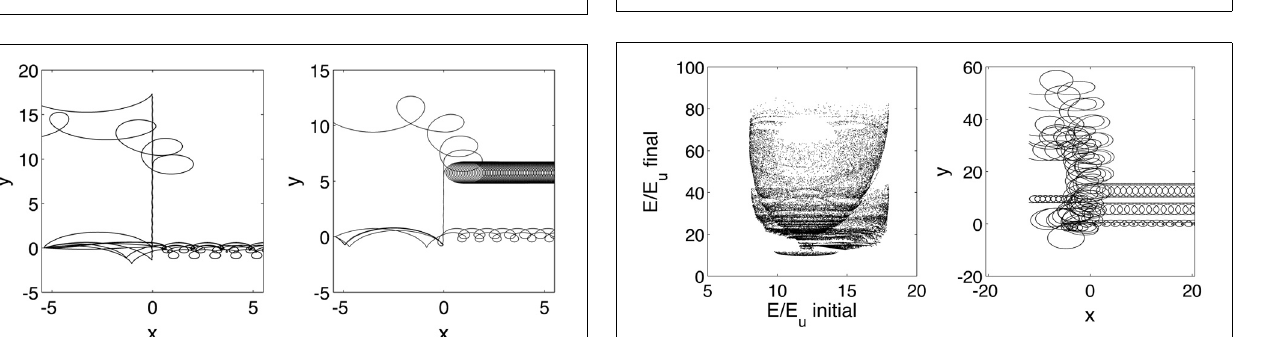
FIGURE 10 | Energy spectrum upstream (stars) and downstream (circles) for pre-accelerated ions. Left: v p = 3, right: v p = 5. For the shock with θ = 80 ◦ , s = 0 . 5, and D = 0 . 2.